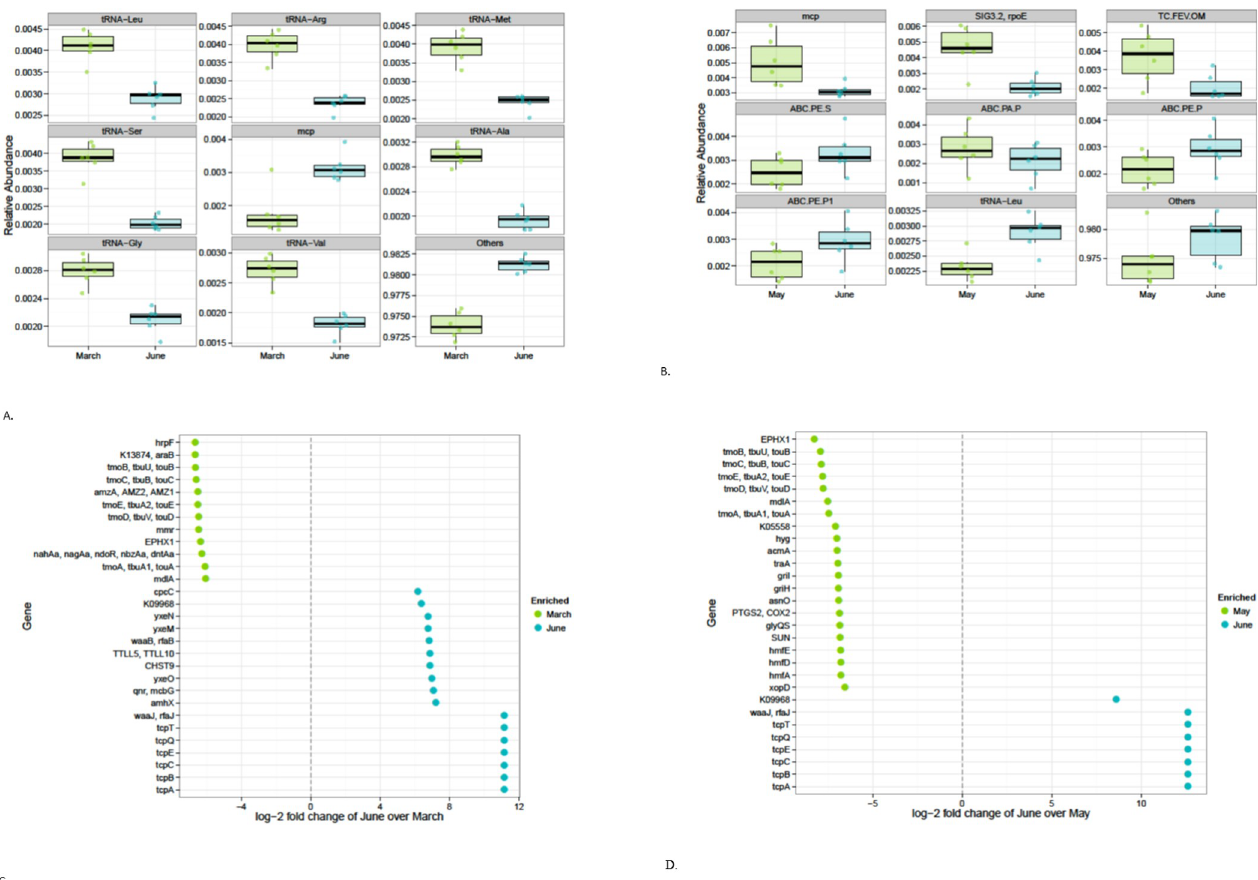
Fig 5. Proportional Abundance of the Top Inferred Genes for March vs. June leaf (Fig 5A). Plot shows the most abundant functional genes. Proportional abundance of the top inferred genes for May vs. June leaf (Fig 5B). Plot shows the most abundant functional genes. KEGG ortholog prediction feature selection for March vs. June leaf (Fig 5C). There were 3,497 significantly different features detected out of 7,127 tested. Only genes with an absolute log-2-fold change greater than 6 and not equal to Inf or -Inf are shown. KEGG ortholog prediction feature selection for May vs. June leaf (Fig 5D). There were 3,033 significantly different features detected out of 7,132 tested. Only 29 genes with an absolute log-2 fold change greater than 6.5 and not equal to Inf or -Inf are shown. Features were considered significant if their FDR-corrected p-value was less than or equal to 0.05, and the absolute value of the log-2 fold change was greater than or equal to